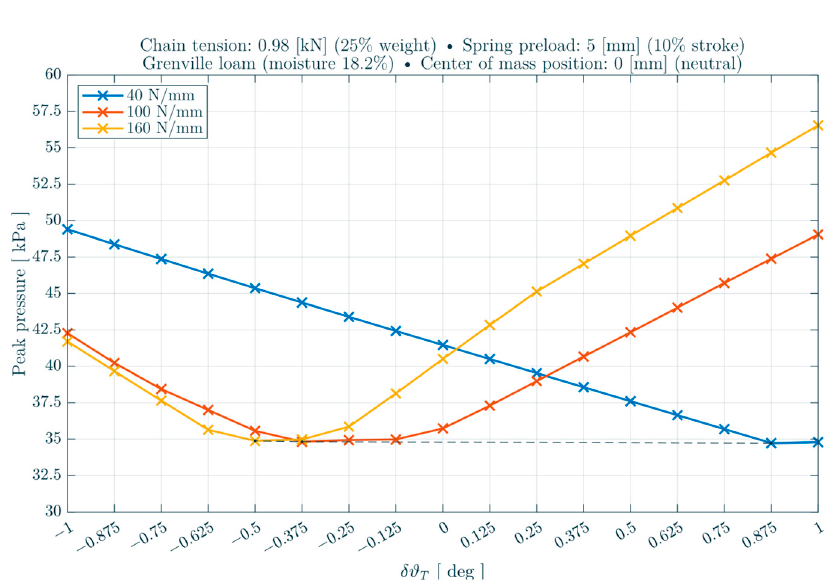
T : chain tension effect.